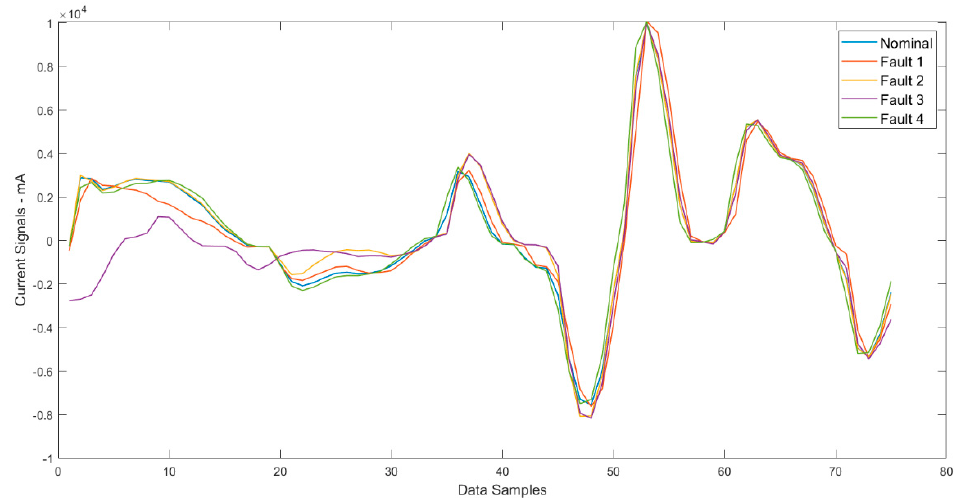
Figure 2. Current signal trends during the nominal condition and the four improper working conditions.